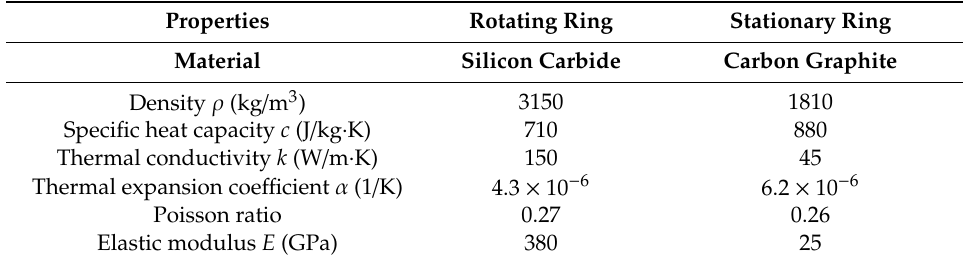
Table 2. The material properties of mechanical seal.